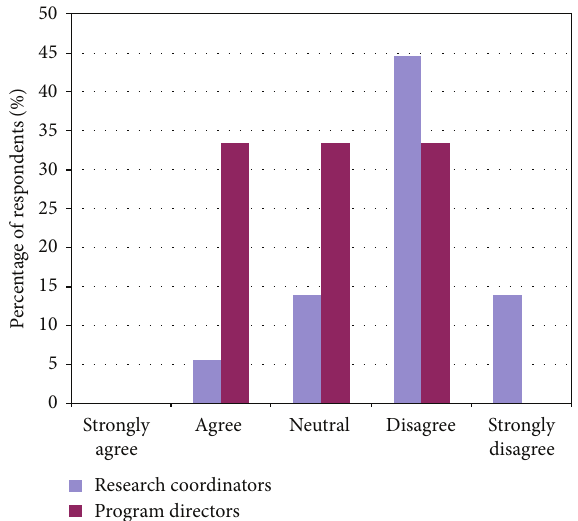
Figure 6: Comparing responses of program directors and research coordinators regarding trainees’ abilities in applying appropriate study design when developing a research project.